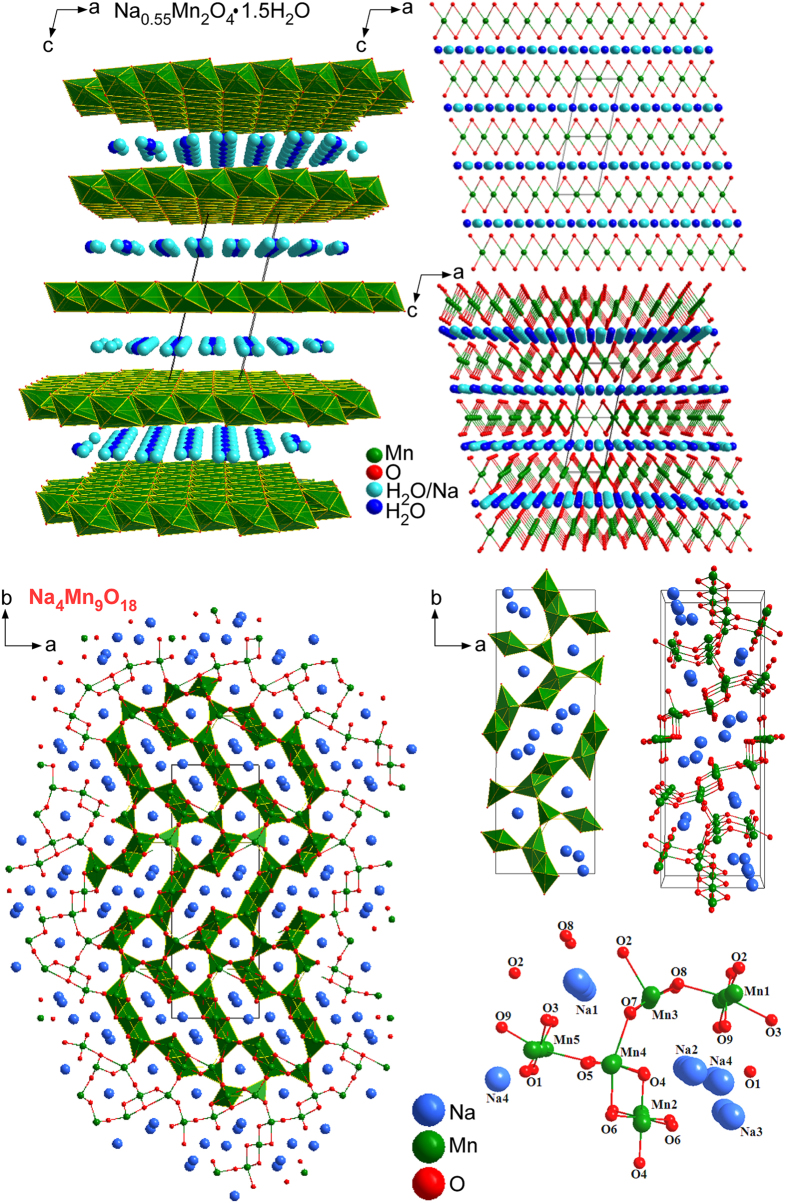
Structure projections and crystal models of Na0.55Mn2O4·1.5H2O (top) and Na4Mn9O18 (bottom).